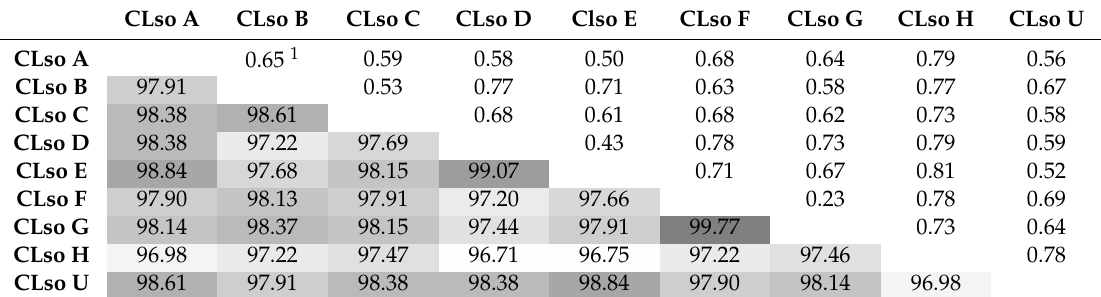
Table 4. Average Similarity ( p -distance) Over All Sequence Pairs Between CLso Groups of Haplotypes Based on Partial Sequences of the 50S Ribosomal Proteins L10 / L12 Genes ( rplJ / rplL ). CLso A CLso B CLso C CLso